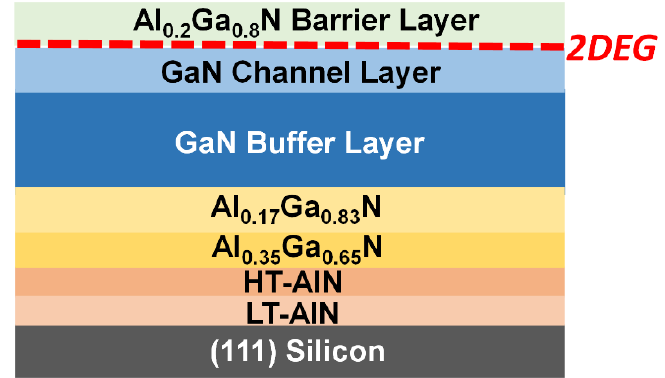
Figure 1. Epi-structure designed for our GaN high electron mobility transistors (HEMTs) with two graded Al x Ga 1−x N strain-compensation transitional layers grown on (111)